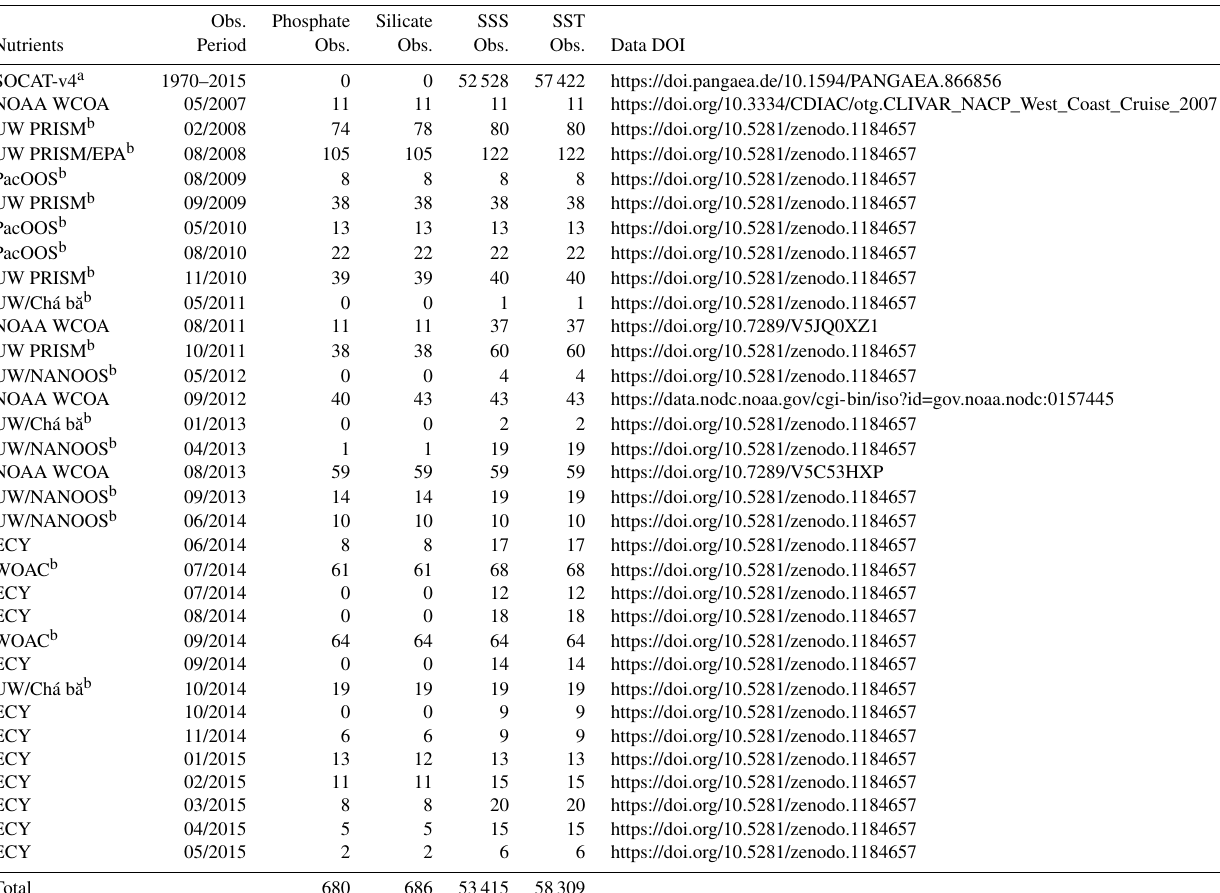
Table A1. Discrete datasets incorporated into the analysis. The observing period and the number of phosphate, silicate, SSS, and SST observations for each cruise are provided. Data DOIs matching those in Table 1 are also listed. Phosphate and silicate samples were analyzed following standard protocols (UNESCO, 1994) during all